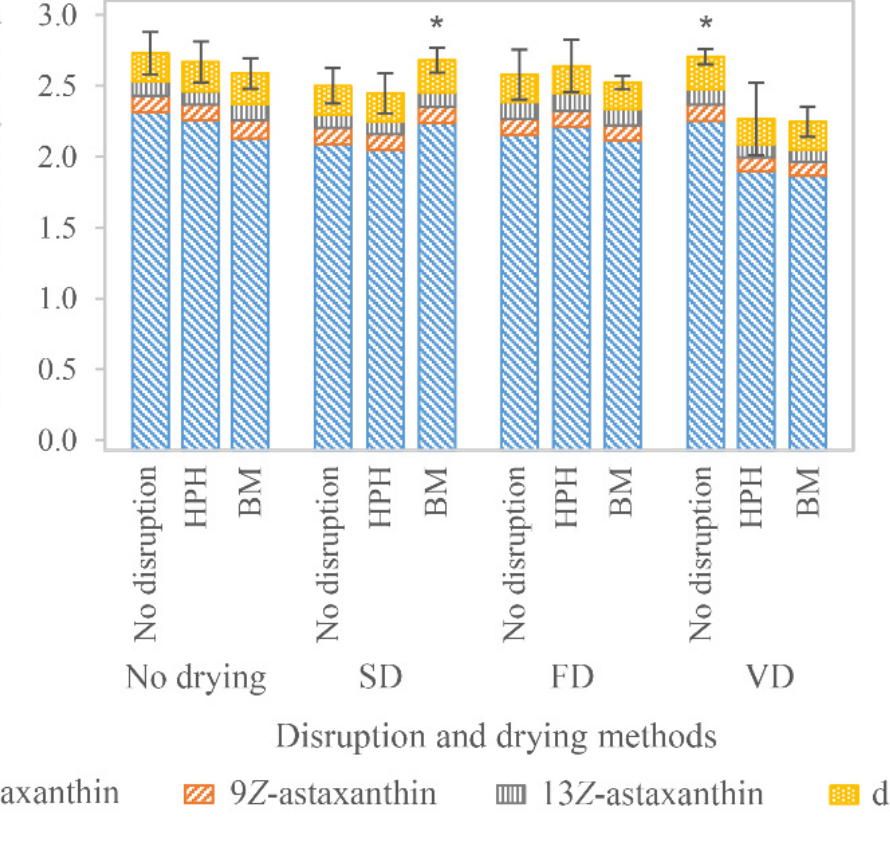
Figure 2. Astaxanthin content in H. pluvialis biomass after various disruption and drying processes. Standard deviation is indicated for total astaxanthin. Stars indicate significant differences ( p < 0.05) from samples dried with the same process. Further significant differences are provided in Table S2.